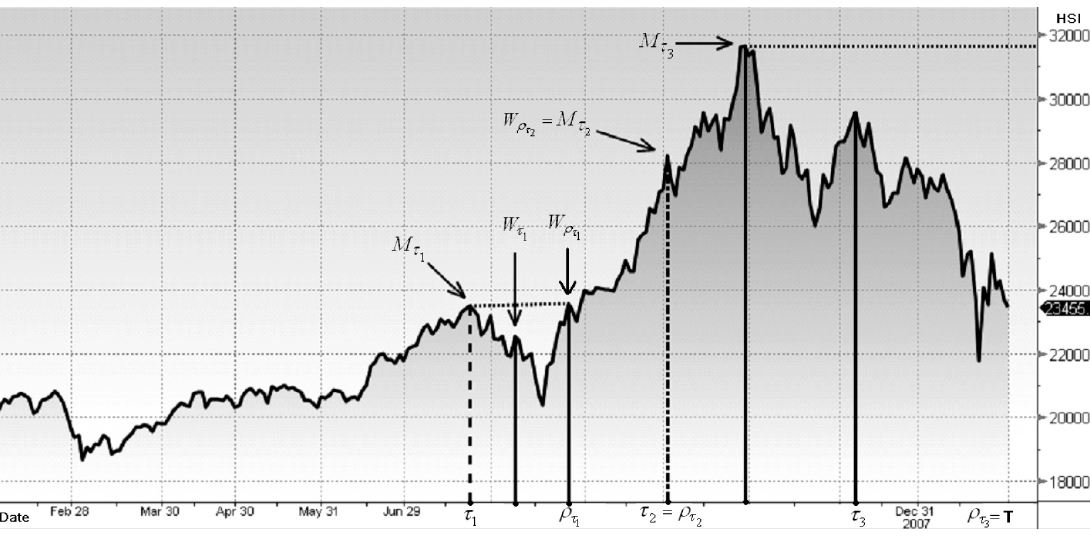
figure 1. relationship between τ and ρ τ in